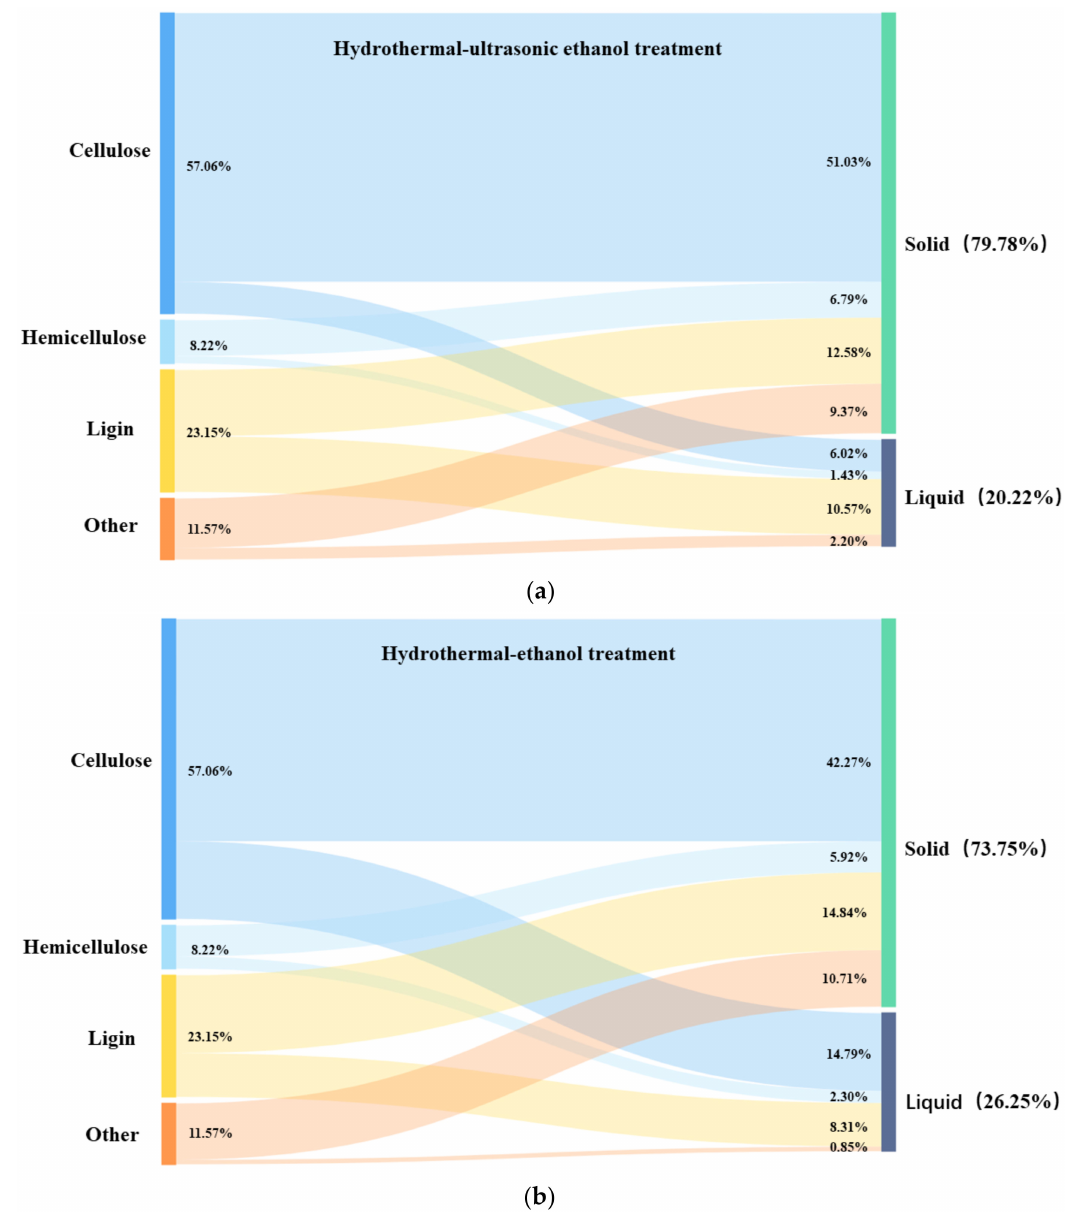
Figure 10. Diagram of the three-component mass flow of hydrothermal